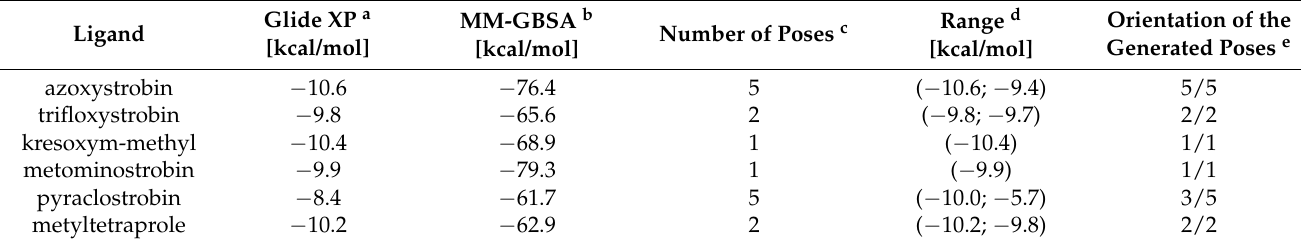
Figure 7. Top-scoring docking poses within the cytochrome b binding pocket of the commercial strobilurin fungicides included in the validation set: ( A ) azoxystrobin, ( B ) kresoxim-methyl, ( C ) metyltetraprole, ( D ) metominostrobin, ( E ) pyraclostrobin (the second top-scoring pose), and ( F ) trifloxystrobin. In ( G ), all validation set poses are reported to highlight their binding mode and the interaction with GLU273. Table 2. Top-scoring docking solutions for all chemicals in the validation set. a Glide XP Score indicates the approx. binding affinity (kcal/mol) of the top-scoring binding pose. b MM-GBSA indicates a more accurate binding affinity (kcal/mol) of the top-scoring binding pose. c Number of poses for each compound obtained by the molecular docking procedure. d Range of the binding affinities (kcal/mol) for each tested chemical of the validation set. e Number of generated poses with an orientation similar to azoxystrobin (as transferred from the template) for each tested compound of the validation